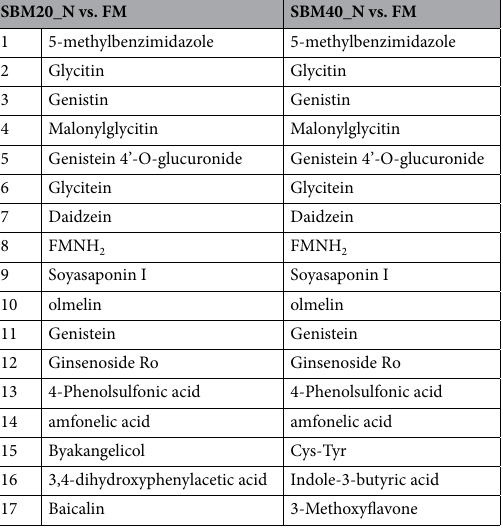
Table 8. Comparison of potential biomarkers of enteritis in intestinal content at different substitute levels (n = 12). No. 1–14 metabolites are the potential “core biomarkers” in DI contents of SBMIE in pearl gentian